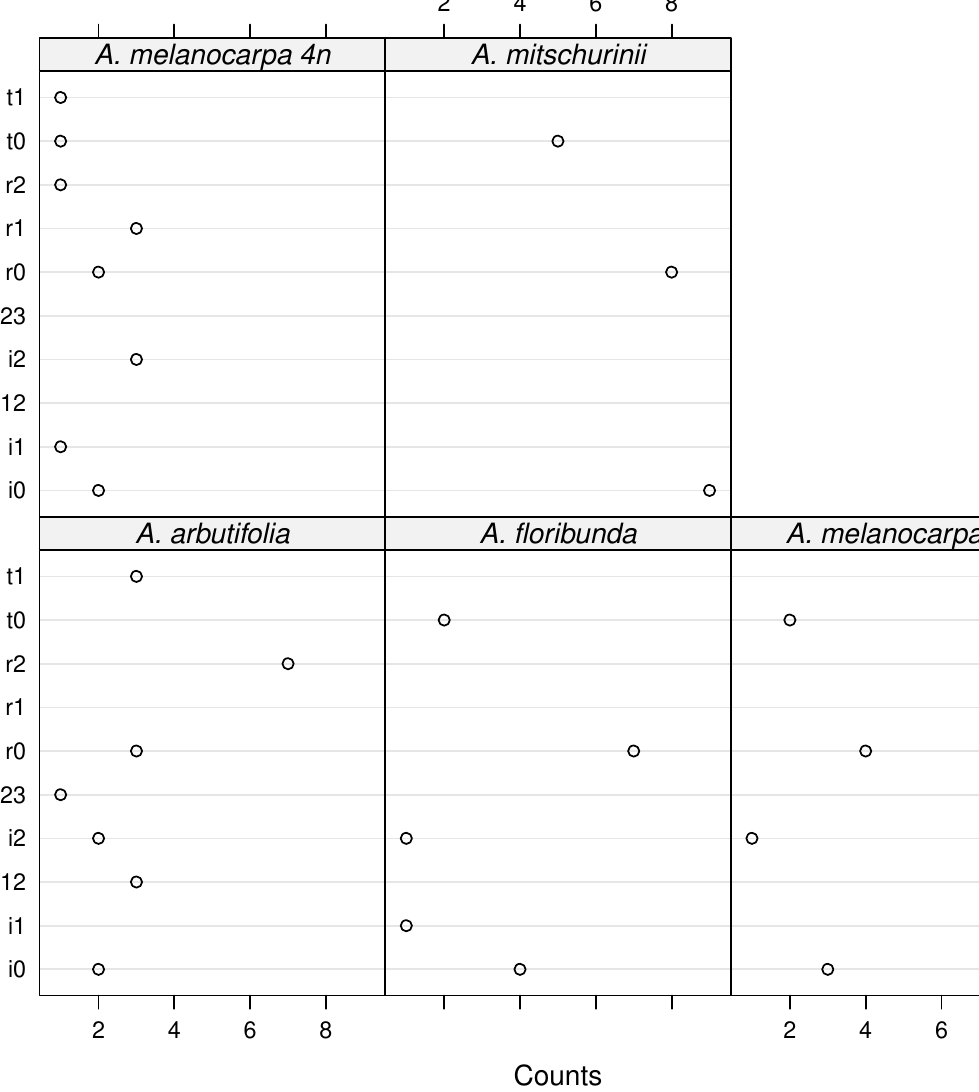
Fig. 2. Abundance of haplotypes per species. Each rectangle is a species. The first letter of haplotype name represent the marker: i for ITS2, r for rbc L and t for trn L-F. Dots correspond with haplotype